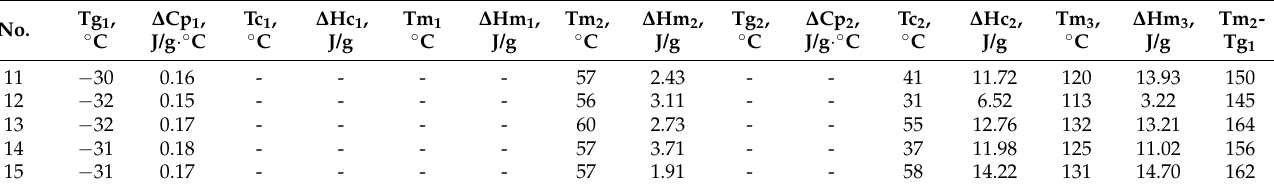
Table A3. Thermal properties of the TPEs of series